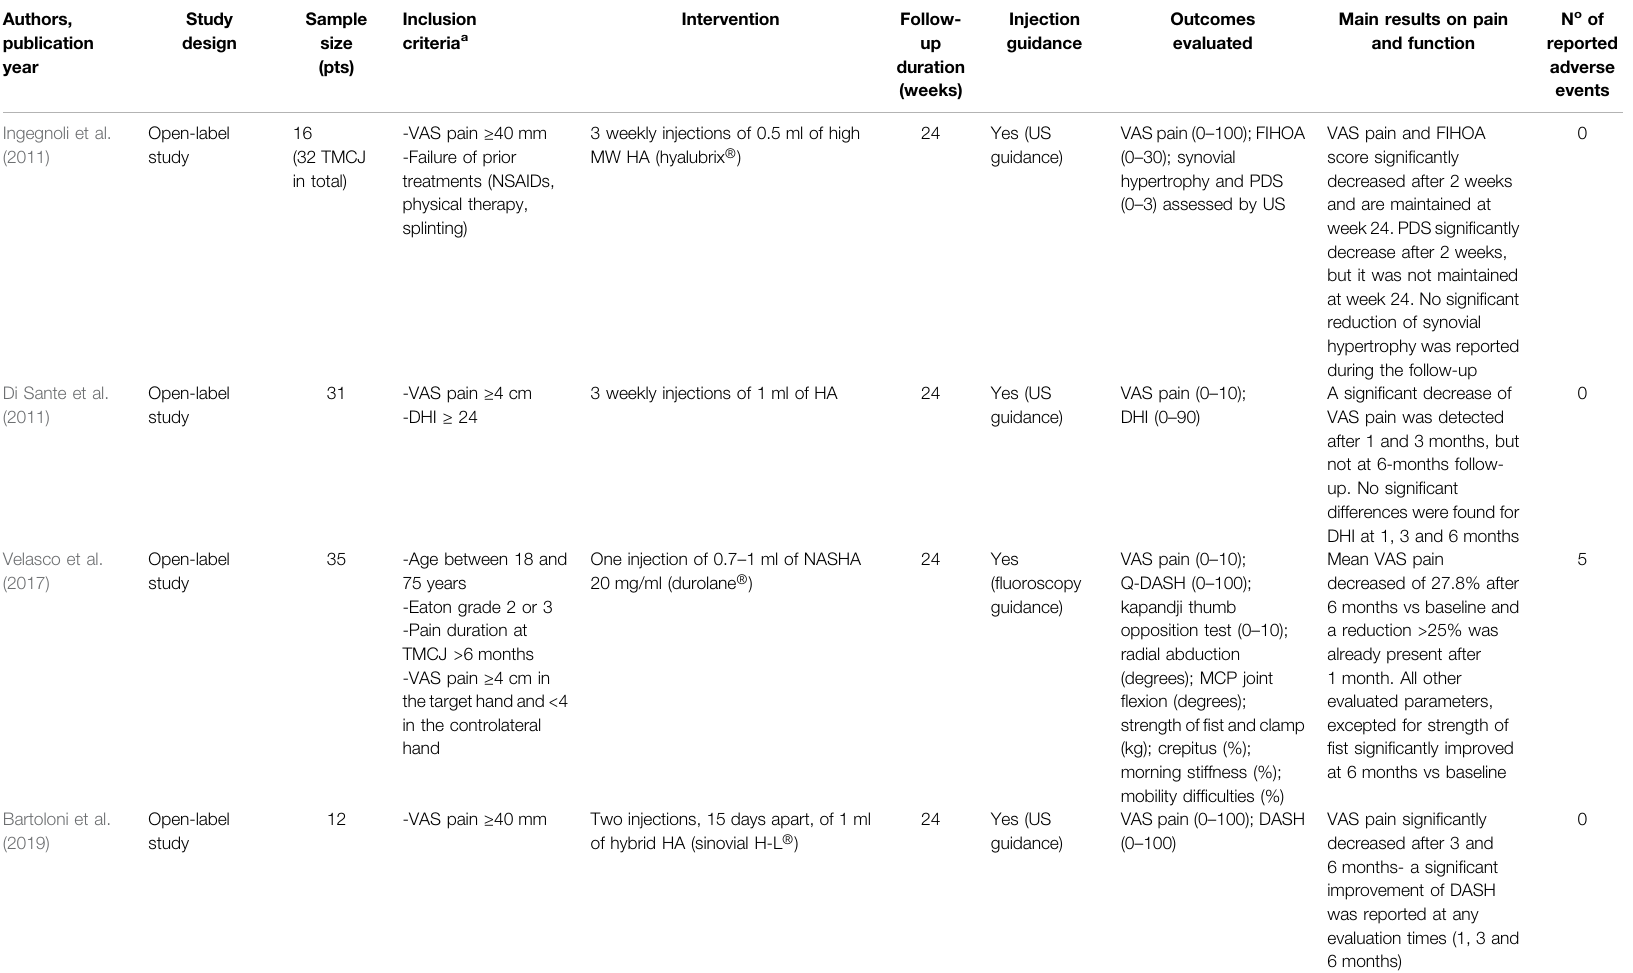
TABLE 2 | ( Continued ) Summary of studies investigating intra-articular injections of hyaluronic acid for the treatment of thumb-base